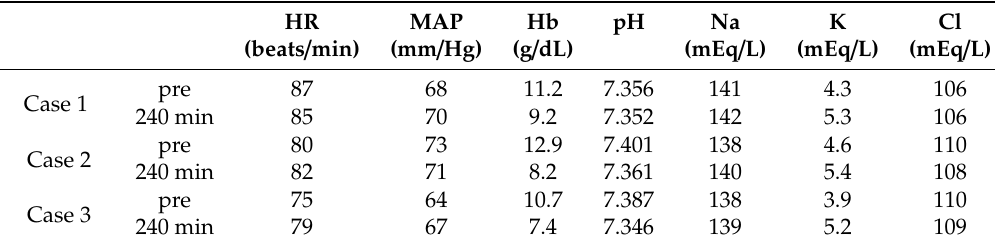
Table 1. Hemodynamic variables, pH, Hb, and levels of electrolytes before and during veno-arterial extracorporeal membrane oxygenation (V-A ECMO).